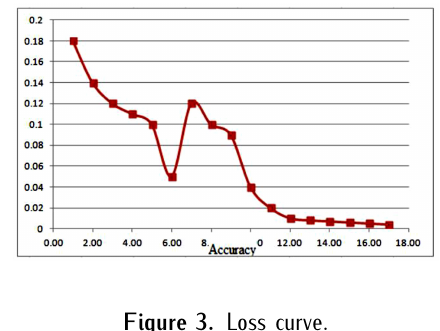
Figure 2. Accuracy obtained from Training.